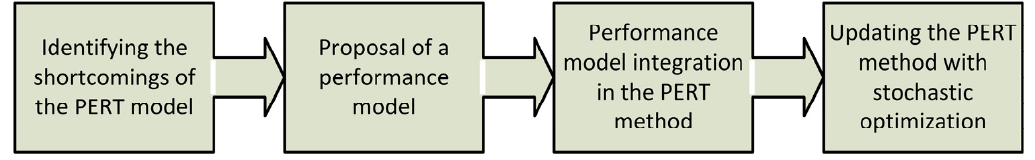
Figure 3. Framework for the research tasks developed in this work.